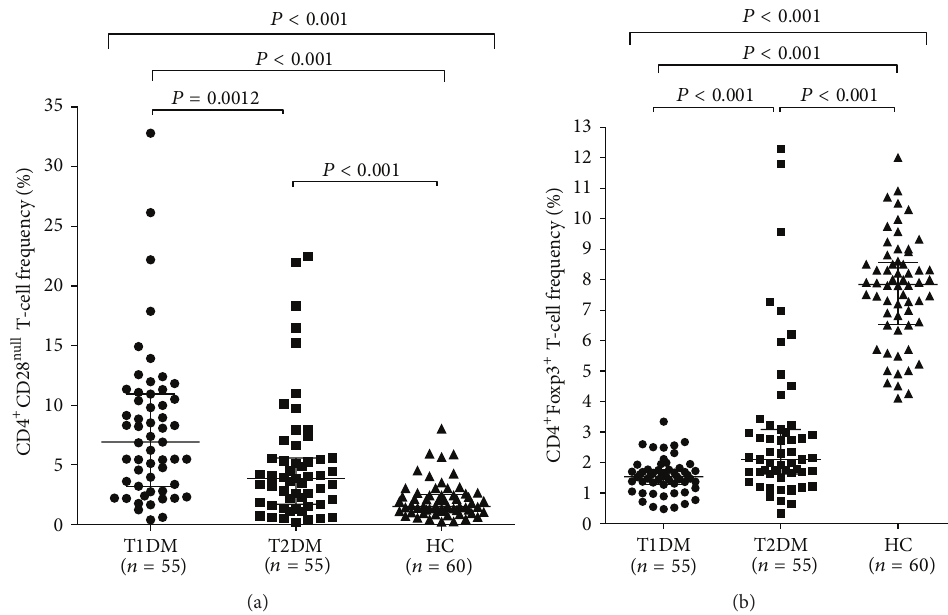
Figure 1: Frequencies of T-cell subsets in different groups. T1DM and T2DM groups were defined according to ADA criteria, while controls were individuals without overt cardiovascular disease and DM. Frequencies of T-cells were determined by two-color flow cytometry. Data are presented as single data points. (a) CD4 + CD28 null T-cell frequencies in different groups. CD4 + CD28 null T-cell frequency was significantly higher in T1DM than in other groups, and it was higher in T2DM than in controls. (b) CD4 + FoxP3 + T-cell frequencies in different groups. CD4 + FoxP3 + T-cell frequency was significantly lower in T1DM than in other groups, and it was lower in T2DM than in controls.